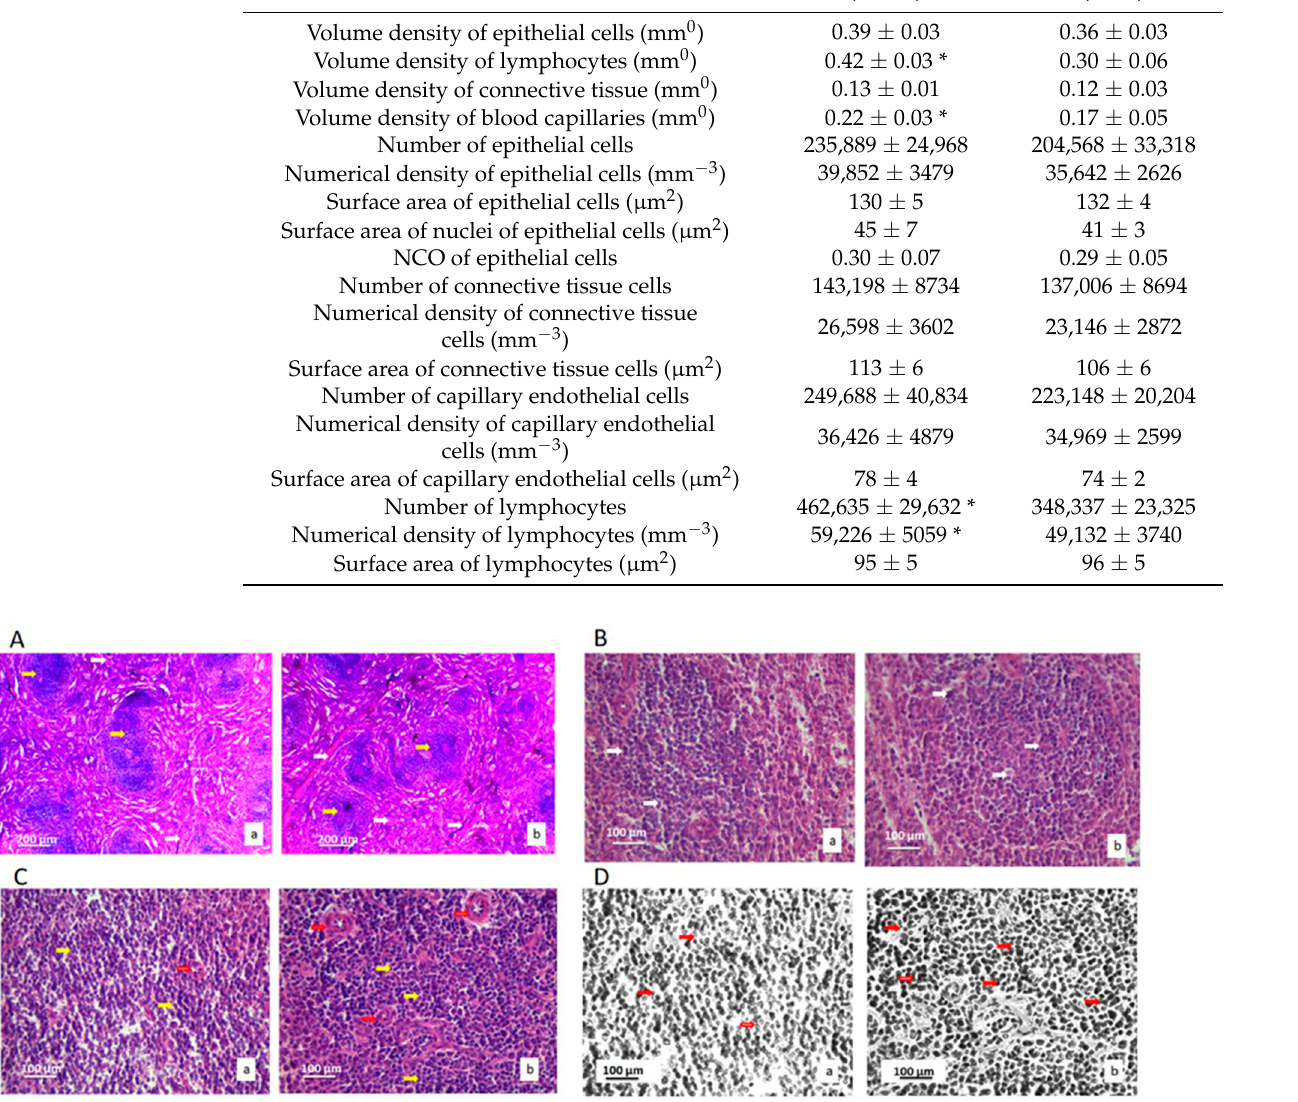
Figure 4. Micrographs of the histological cross-section of the rat spleen of the control group (a) and the treated group (b), (H&E). ( A ) White arrows show connective tissue, and red arrows show lymphatic tissue. Magnification 200×. ( B ) White arrows show epithelial cells. Magnification 50×. ( C ) Yellow arrows show lymphocytes, and red arrows show blood vessels. Magnification 50×. ( D ) Red arrows show lymphocytes. Magnification 50×; digitally processed RGB technique.